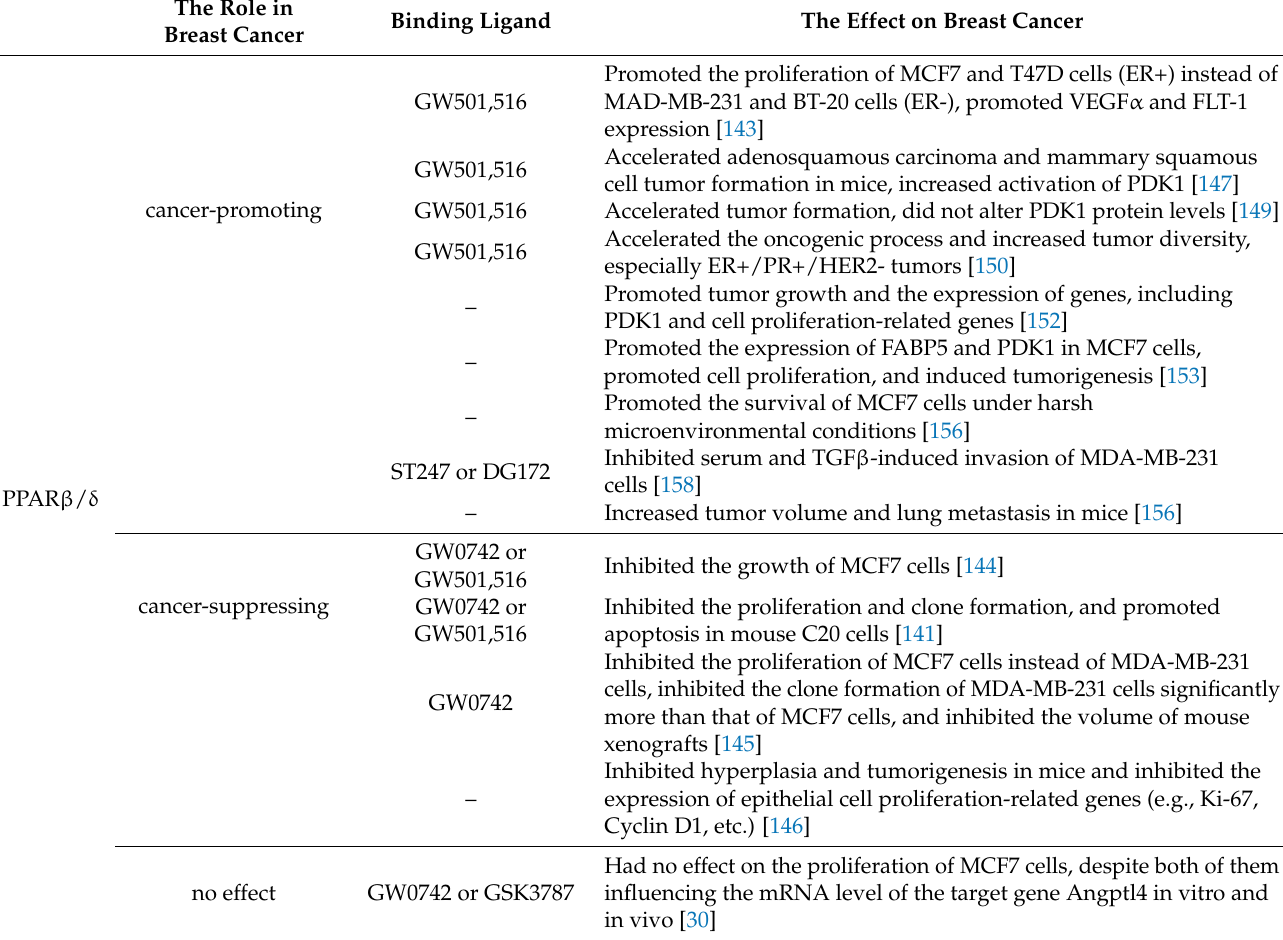
Table 3. The effects of PPAR β / δ on breast